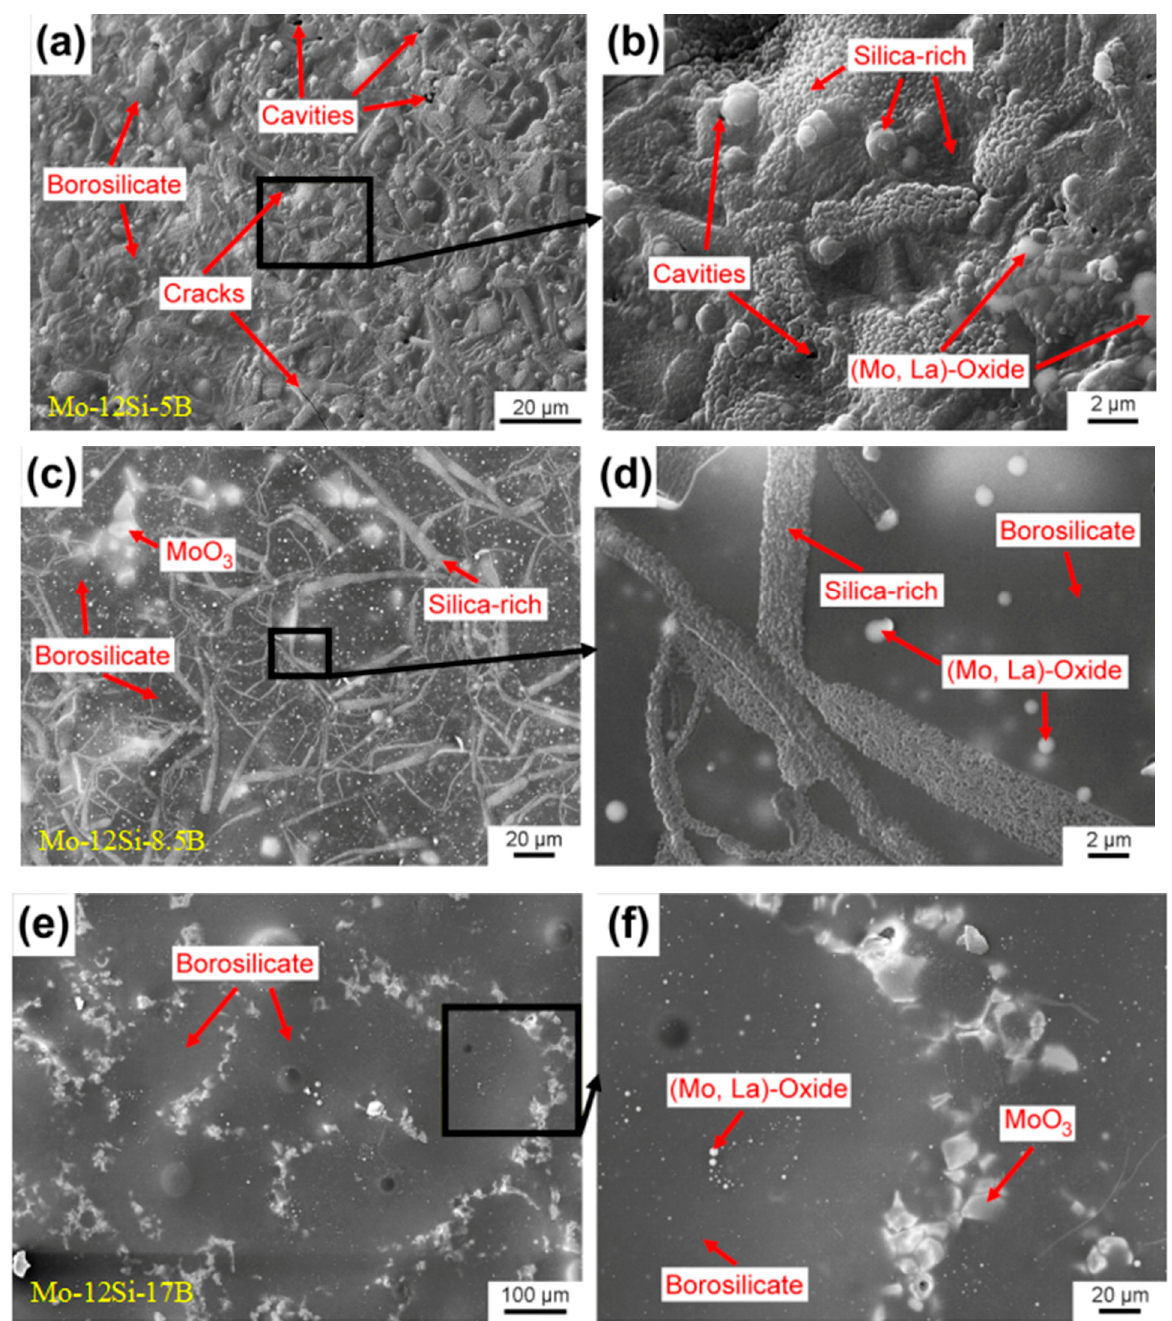
Figure 6. Morphology of Mo-Si-B alloys with different B content after isothermal oxidation for 30 h: ( a , b ) Mo-Si-5B; ( c , d ) Mo-Si-8.5B; ( e , f ) Mo-Si-17B [56].